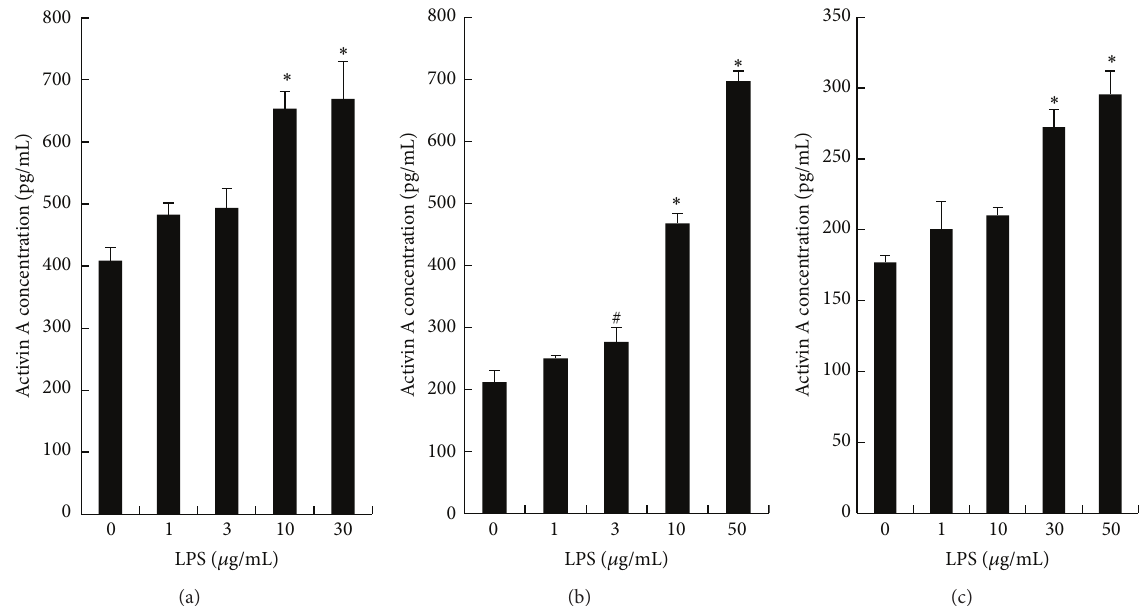
Figure2:Dose-dependenteffectsofLPSonactivinAsecretioninthreeindependentexperiments.Fetalmembraneswereobtainedfromthree patients,andAECfromeachpatientwereculturedindependentlyatadensityof20,000cellsperwellinDME/Ham’s12mediumsupplemented with 10% FBS, 100 𝜇 g/mL streptomycin, 0.5 𝜇 g/mL amphotericin B, and various concentrations of LPS for 96h. Each independent result is shown in panels (a), (b), and (c). The results are shown as the mean ± SE ( 𝑛 = 4 ). # 𝑃 < 0.05 compared with the control (LPS; 0ng/mL) value. ∗ 𝑃 < 0.01 compared with the control (LPS; 0ng/mL)